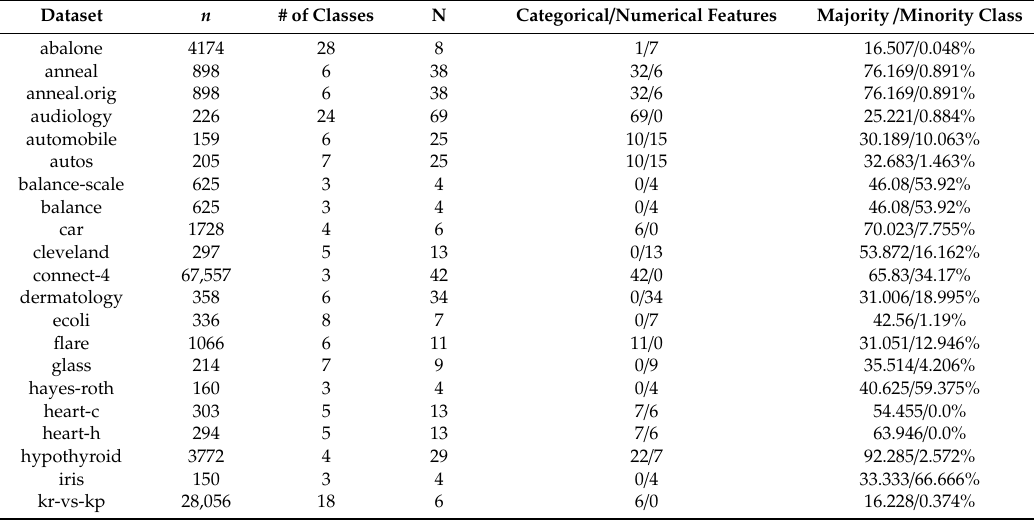
Table 2. Formulation of the examined multi-class